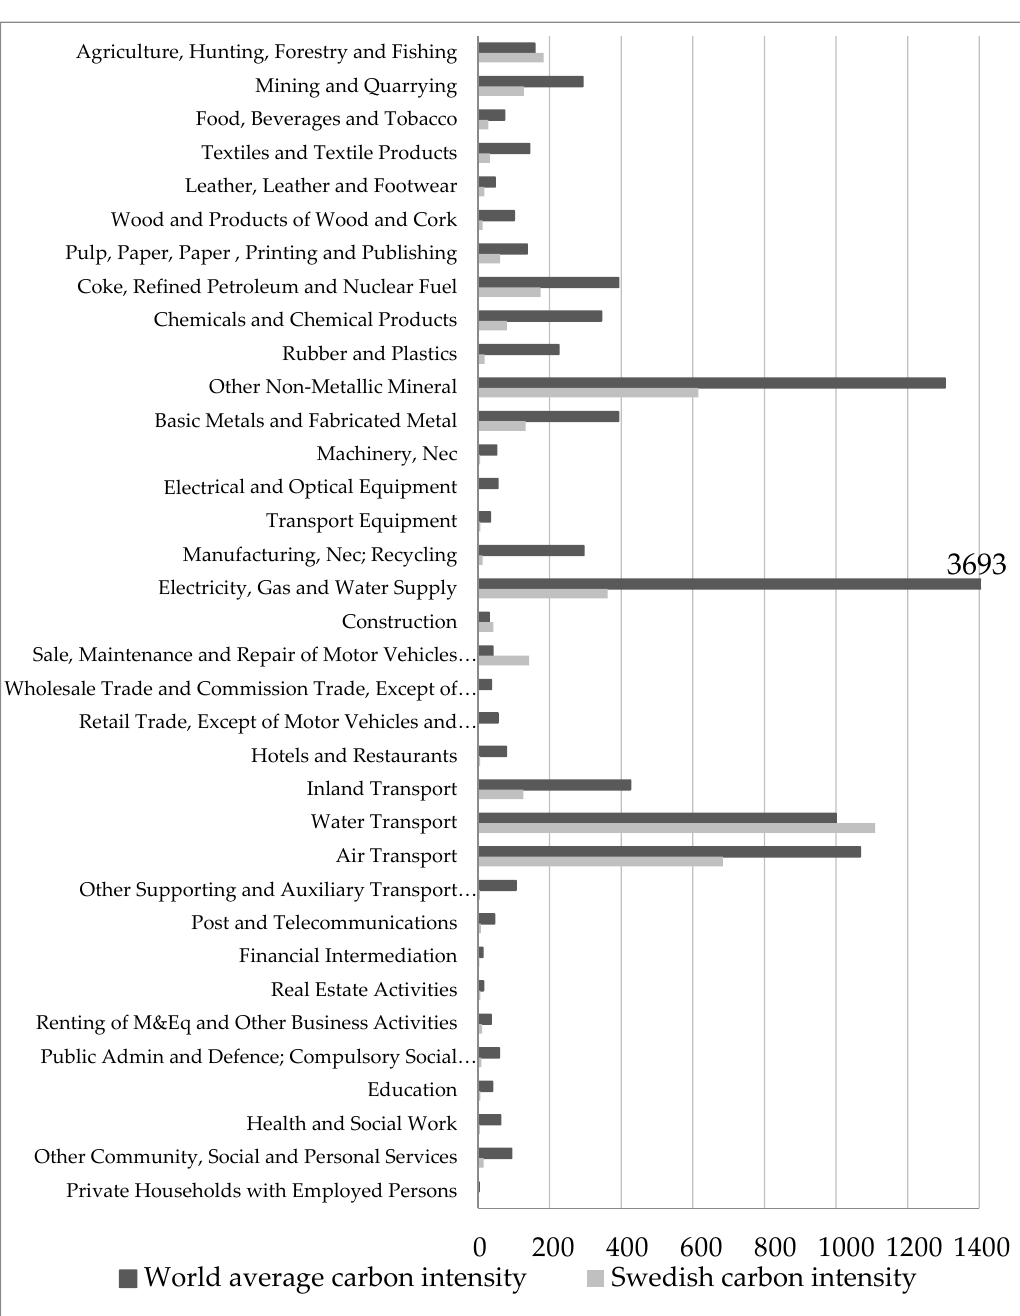
/ $ of production, in green) v. world average (grey) in 2